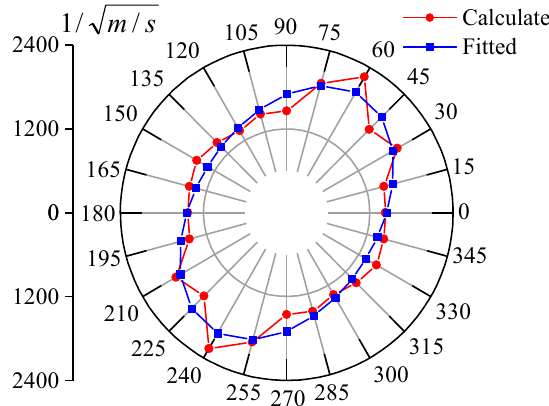
Figure 7. Fitting of hydraulic conductivity with an ellipse.